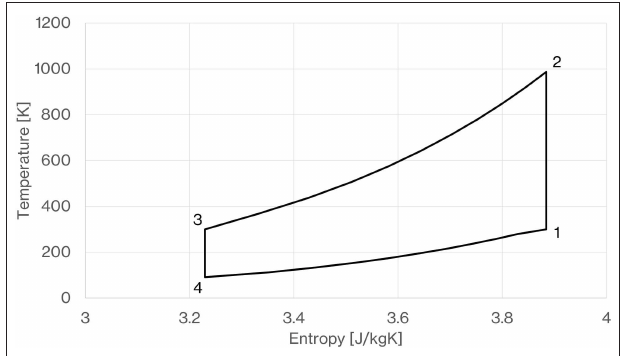
FIGURE 1 | Temperature-Entropy diagram for ideal PTES system, charge mode is anticlockwise, discharge mode is clockwise.